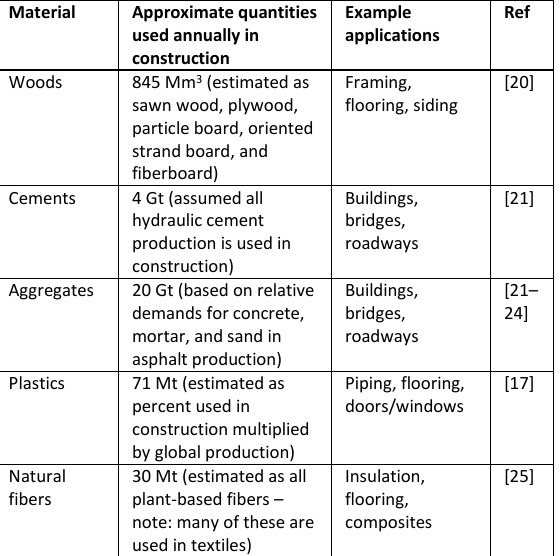
Table 1. Summary of annual demand of infrastructure materials for which sequestration is commonly discussed.